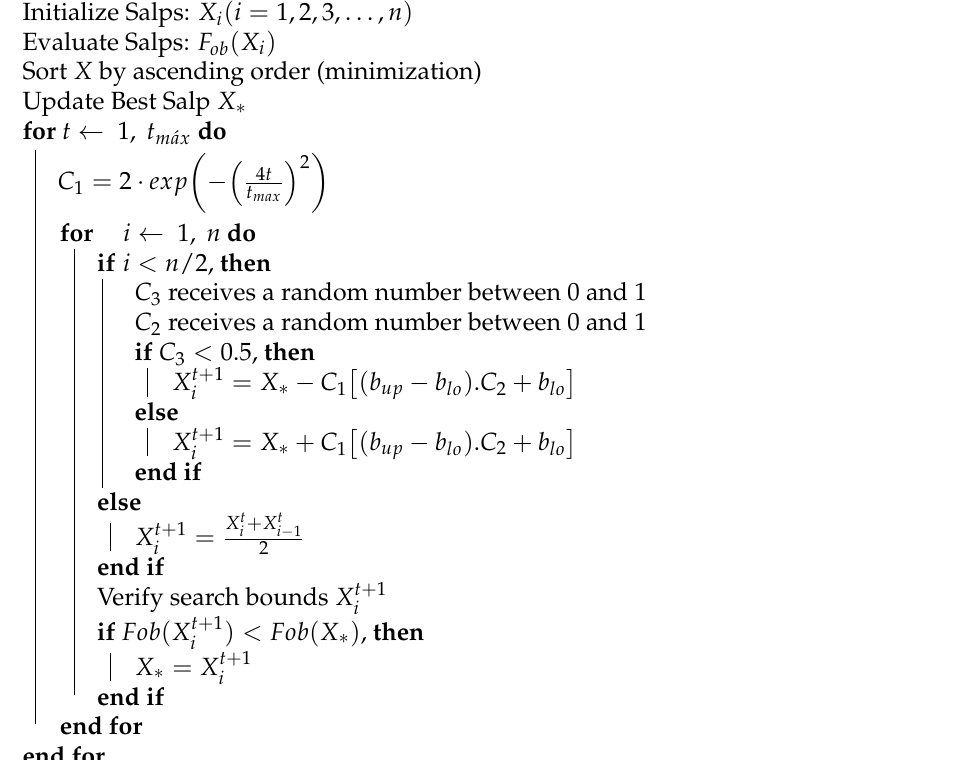
Algorithm 3 Salp Swarm Algorithm (SSA)